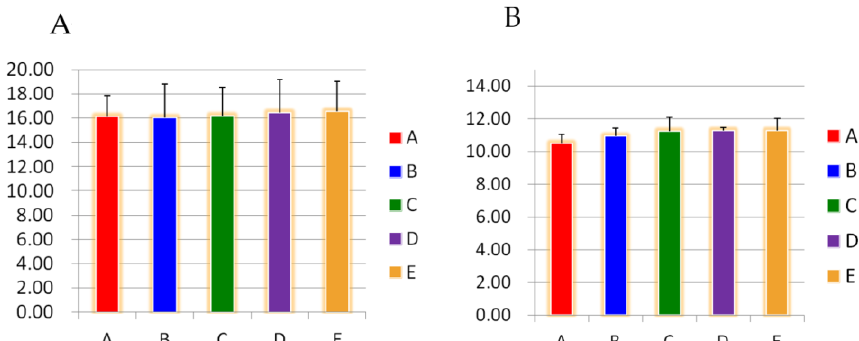
Figure 2. ( A ) Effects of different GSP groups on GH levels in the blood of rats. ( B )Effects of different GSP groups on INS levels in the blood of rats. Values of the different groups with small letter superscripts mean significantly different ( p < 0.05).